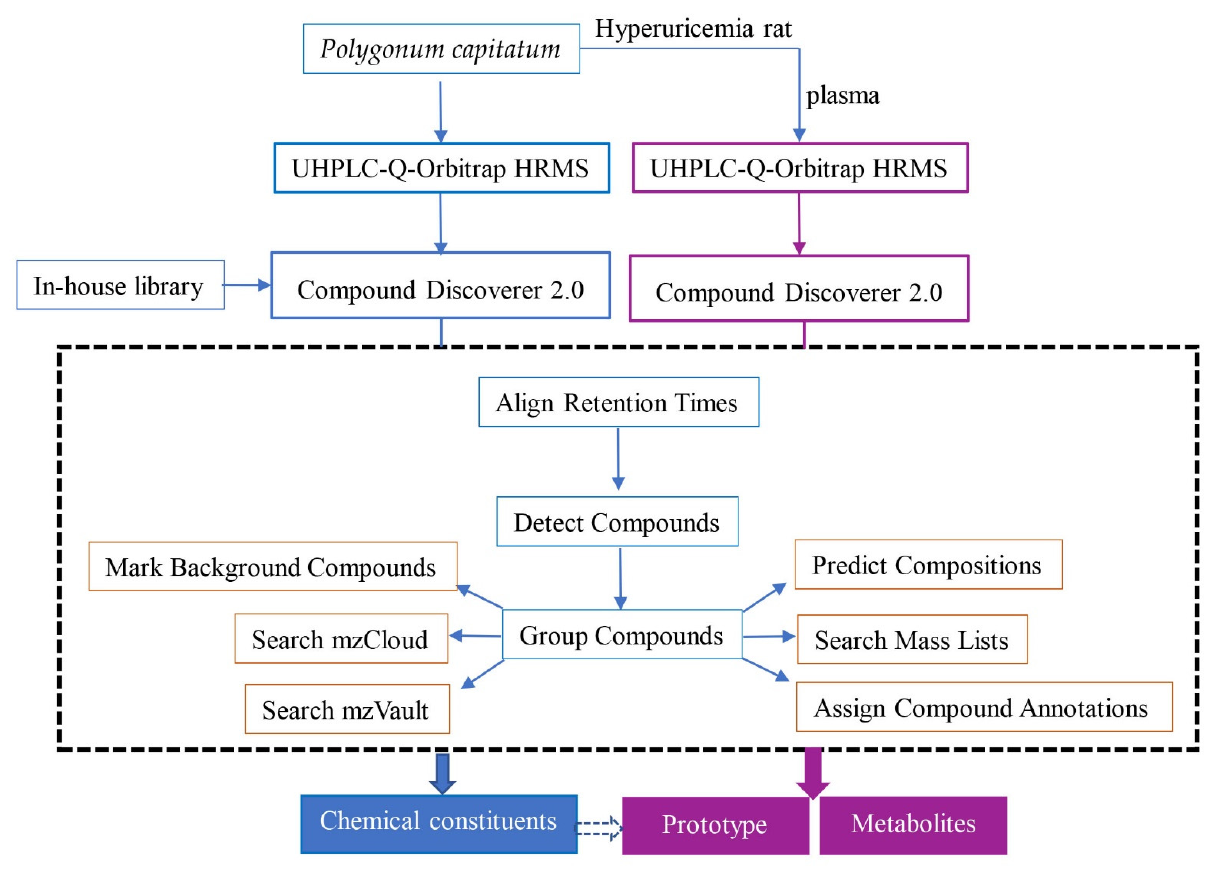
Figure 7. The data processing workflow for identification of chemical ingredients from P. capitatum and its absorbed constituents in hyperuricemia rat plasma.